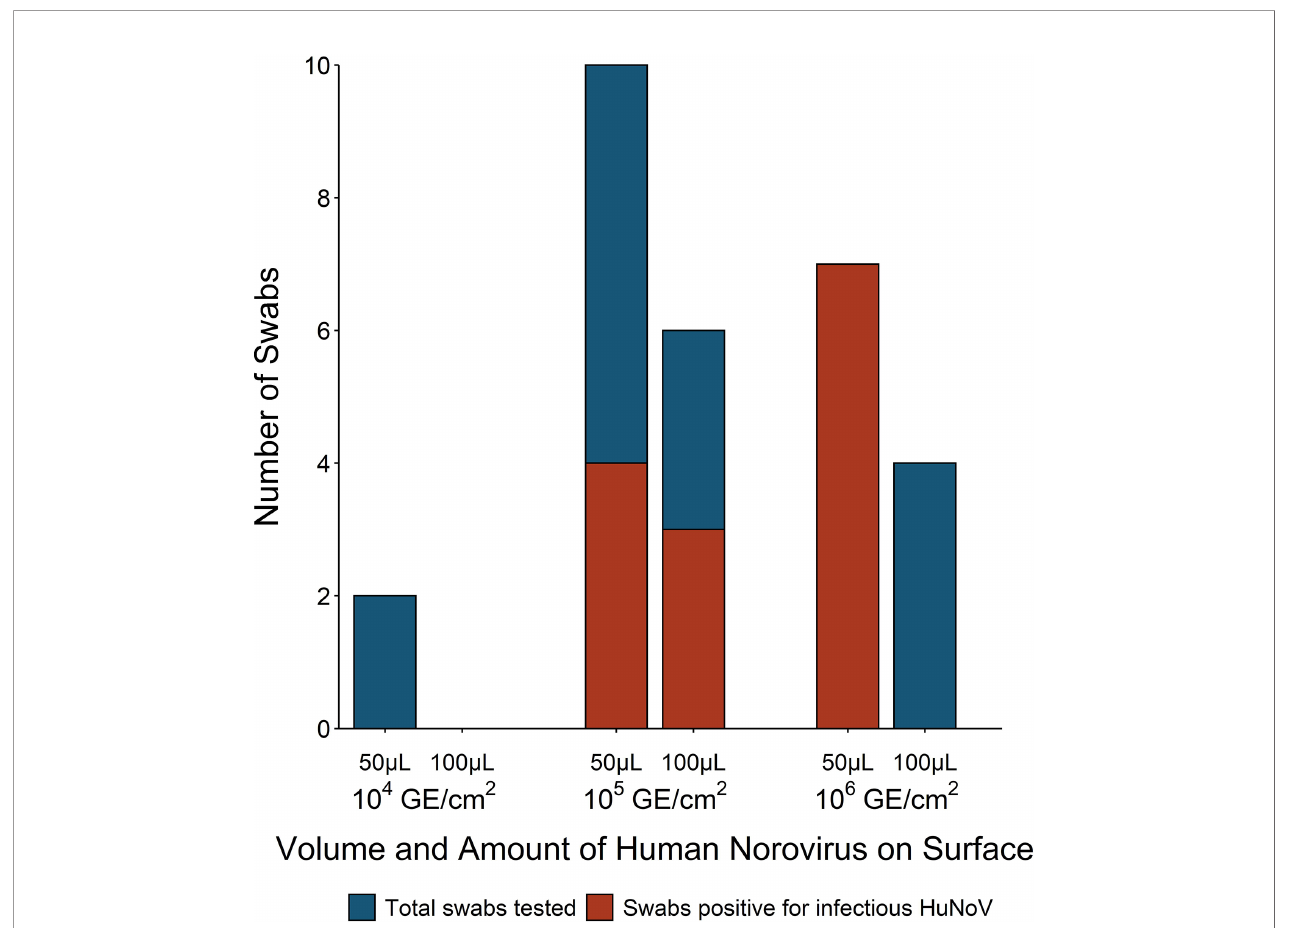
FIGURE 3 | Number of fomite-recovered swabs that were tested and positive for infectious human norovirus (HuNoV) by surface inoculum volume and amount of HuNoV on fomite [genome equivalents (GE)/3 cm 2 ]. Non-porous laminated fi berboard from a hospital bed tray was inoculated with either 50 or 100 ml HuNoV stool suspension containing 10 4 , 10 5 , or 10 6 HuNoV GE/3 cm 2 . Fomites were swabbed with macrofoam swabs pre-moistened in phosphate buffered saline plus 0.02% Tween80. Human intestinal enteroid (HIE) monolayers were infected with swab eluate and were considered positive for infectious HuNoV if the fold increase in HuNoV GE between 1 and 72 h post infection (hpi) exceeded fi